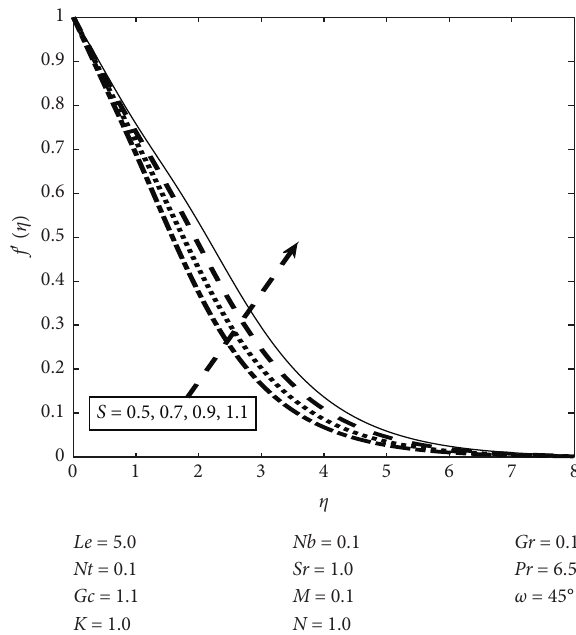
Figure 6: Velocity profile for several values of Gc .